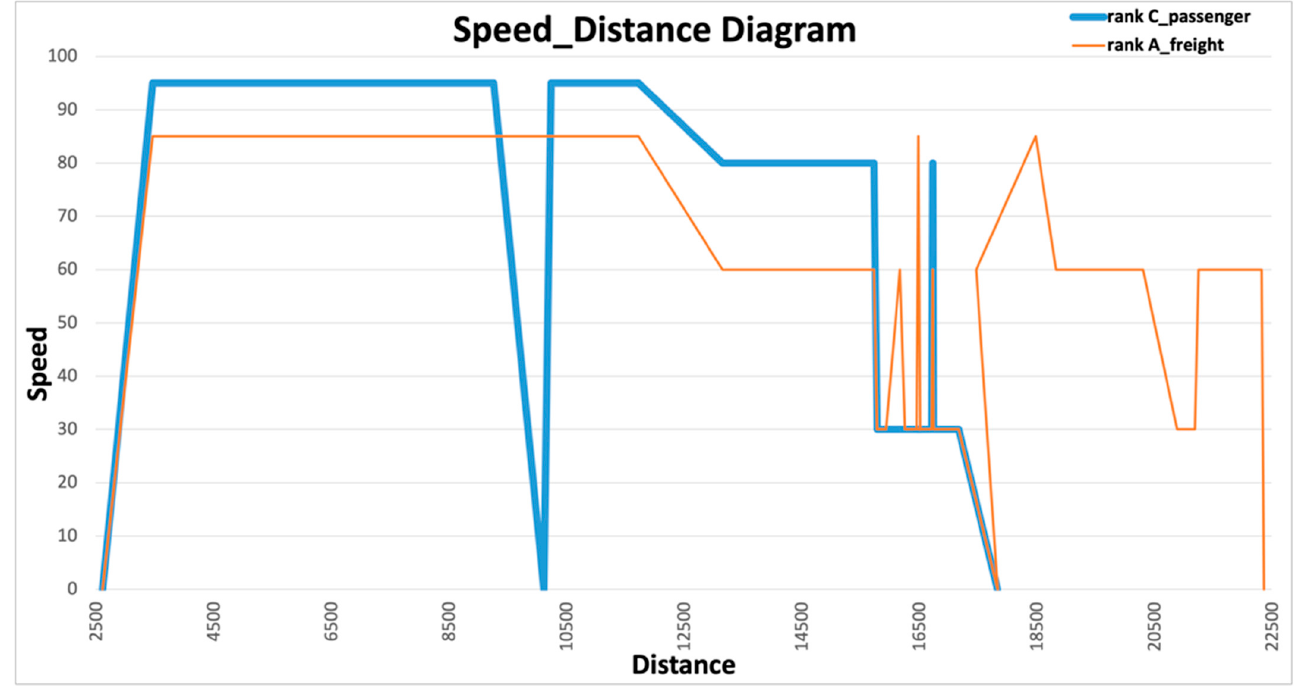
Figure 4. Speed–distance diagram for Trieste Centrale in blue, and Trieste Campo Marzio in red.